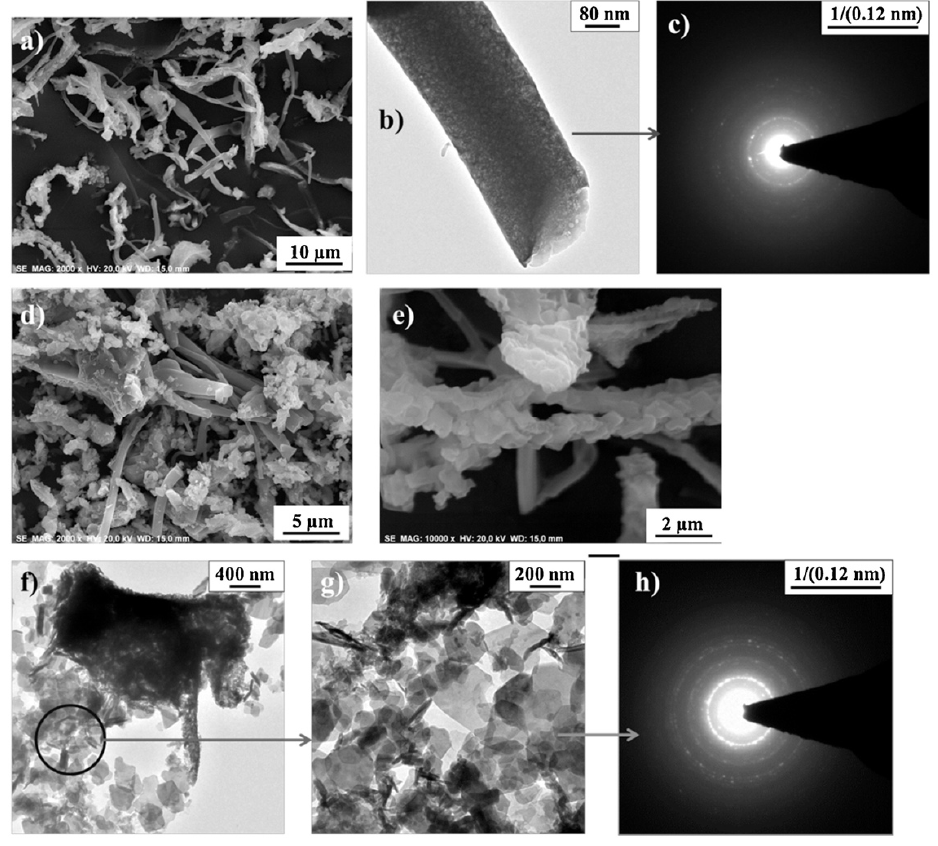
Figure 3. SEM and TEM ( a , b , d – g ) images of VPO fibrous catalysts at different magnifications and SAED analysis ( c , h ). Reproduced with permission from the copyright owner (Elsevier 2016) from Ref. [39].